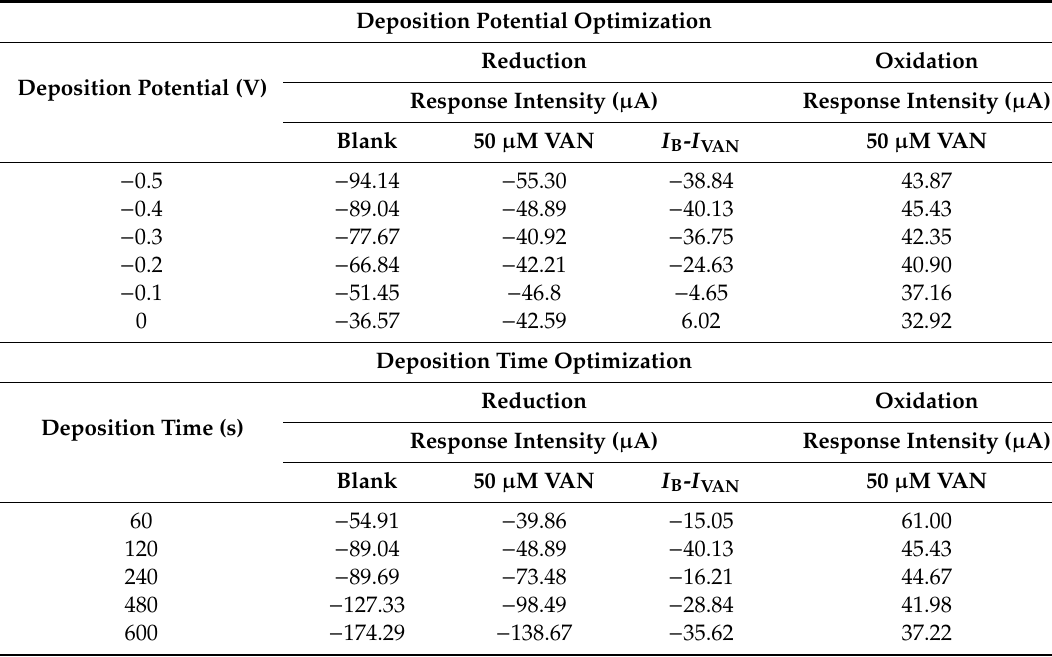
Table 1. Optimization of the electrogeneration procedure.